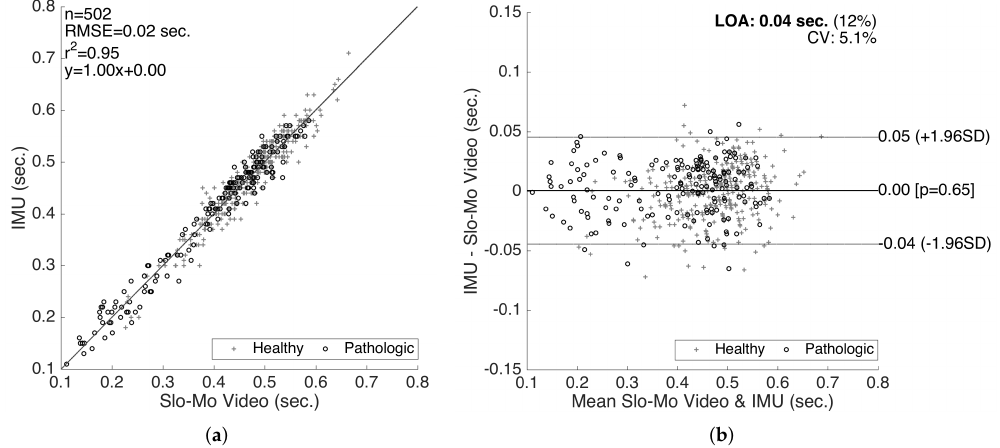
Figure 15. Swing time validation. ( a ) correlation plot and ( b ) Bland–Altman